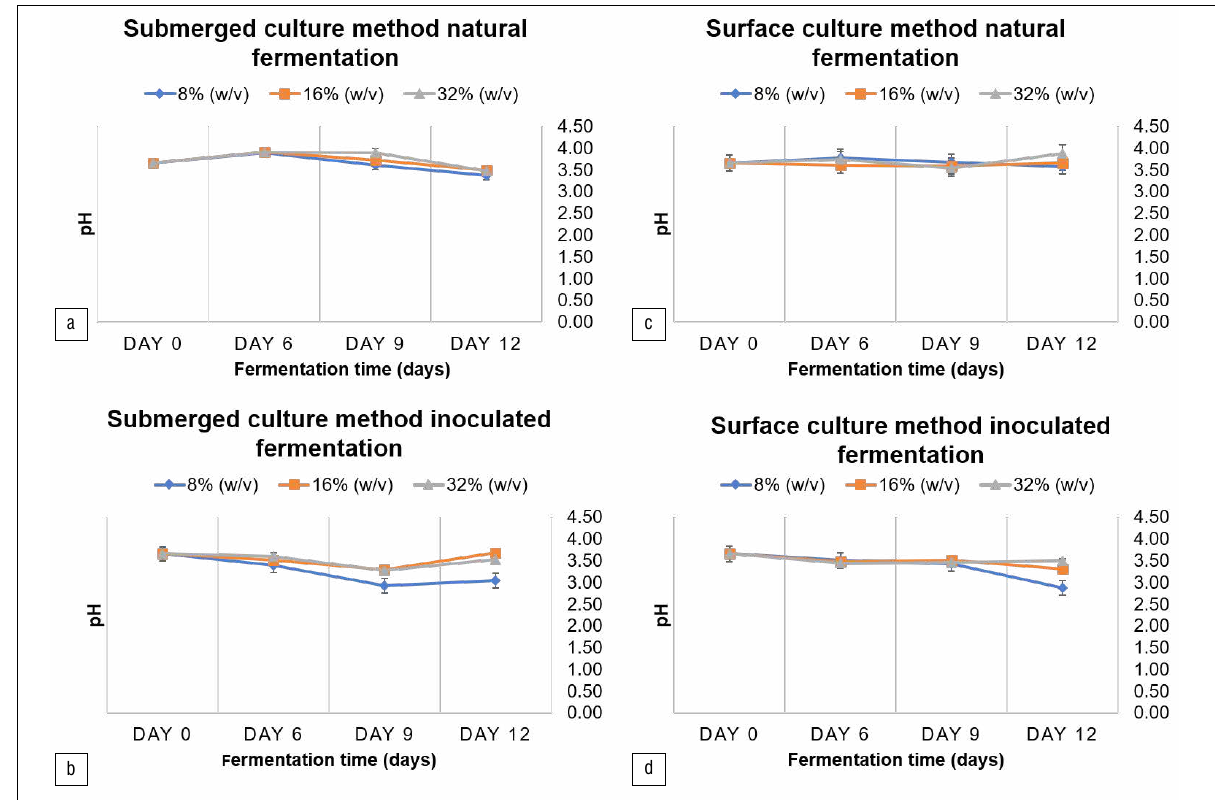
figure 2: pH of marula vinegar over a period of 12 days, using natural and inoculated fermentation techniques, the submerged culture method (a, natural and b, inoculated) and the surface culture method (c, natural and d, inoculated). Mean values are for seasons 1 and 2 combined ( n